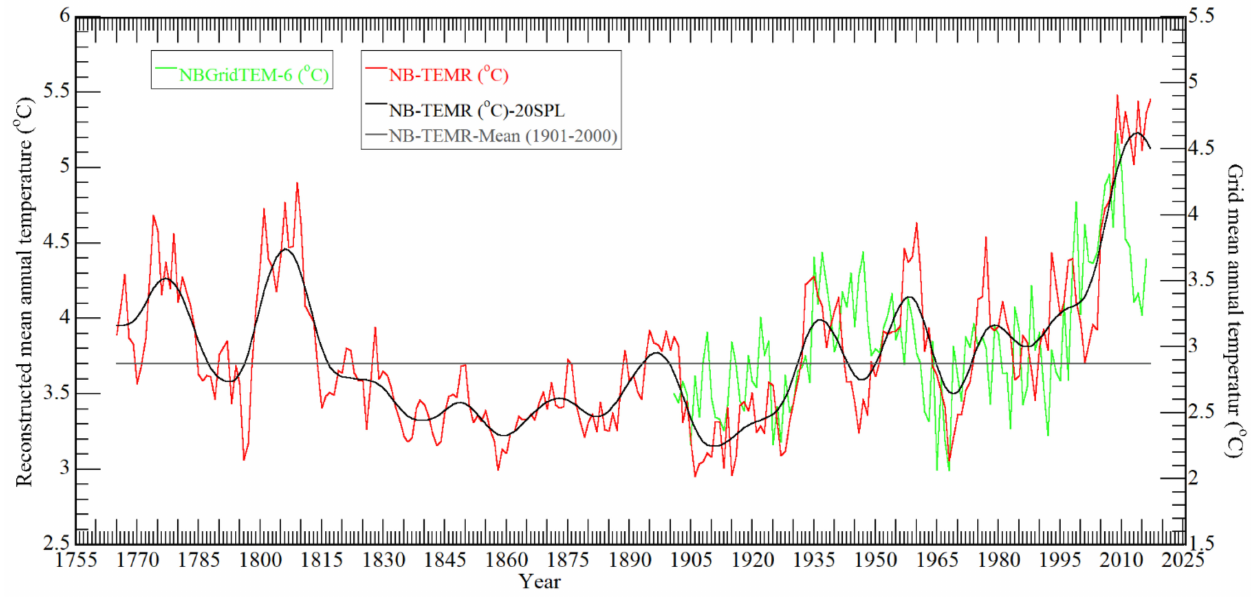
Figure 3. Mean annual temperature over Northern Bhutan—NB-TEMR (red line with grey spline) and NBGridTEM-6 (aquamarine line). Reconstruction data has been filtered by 20-year Low Pass Filtered smoothing. Perfect superimposition of lines between NB-TEMR over NBGridTEM-6 displays strong significant relationship ( p < 0.001) between two